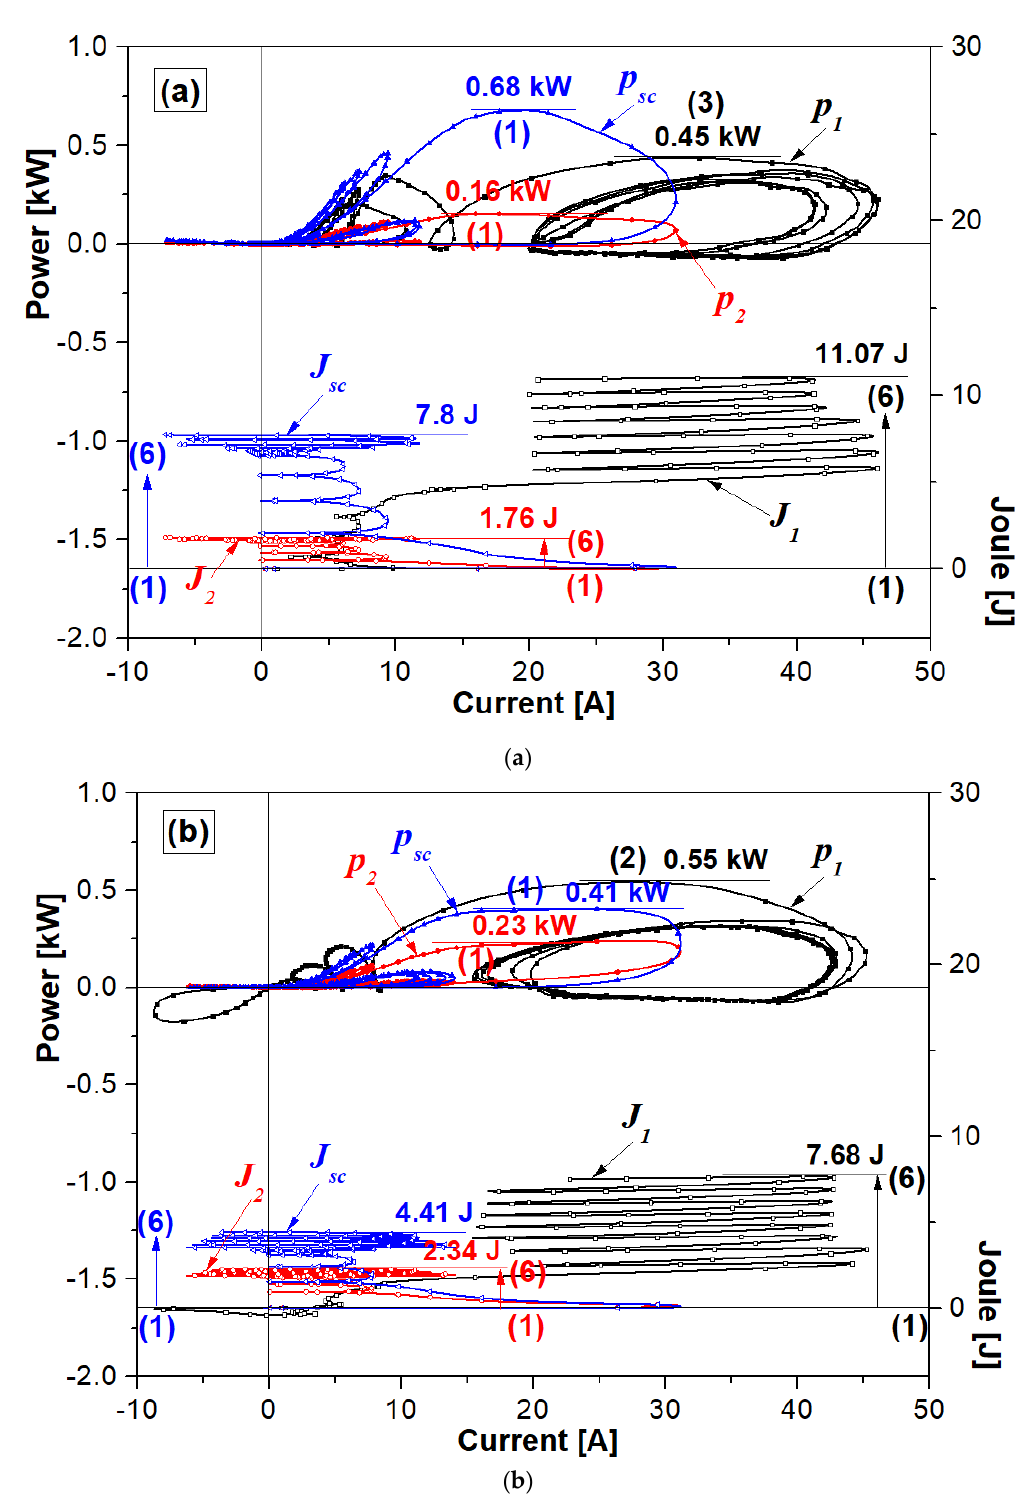
Figure 6. Current vs. power consumption and energy consumption characteristics of each device according to the connection direction between N 1 and N 2 during the fault cycle. ( a ) In the case of the subtractive polarity winding. ( b ) In the case of the additive polarity winding.